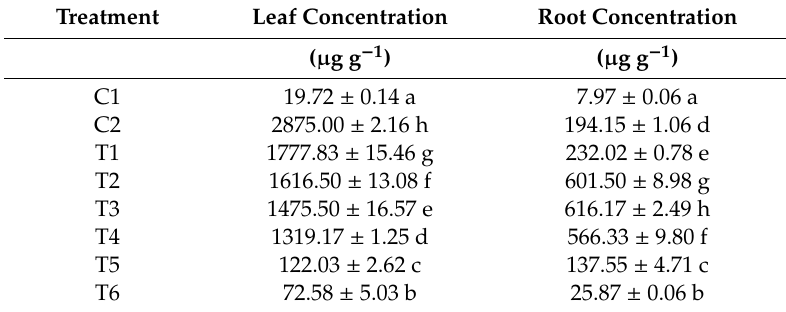
Table 1. Effects of IAA on the Cu Accumulation by Cu-Stressed Spinach Seedlings. Table 1. E ff ects of IAA on the Cu Accumulation by Cu-Stressed Spinach Seedlings. Treatment Leaf Concentration Treatment